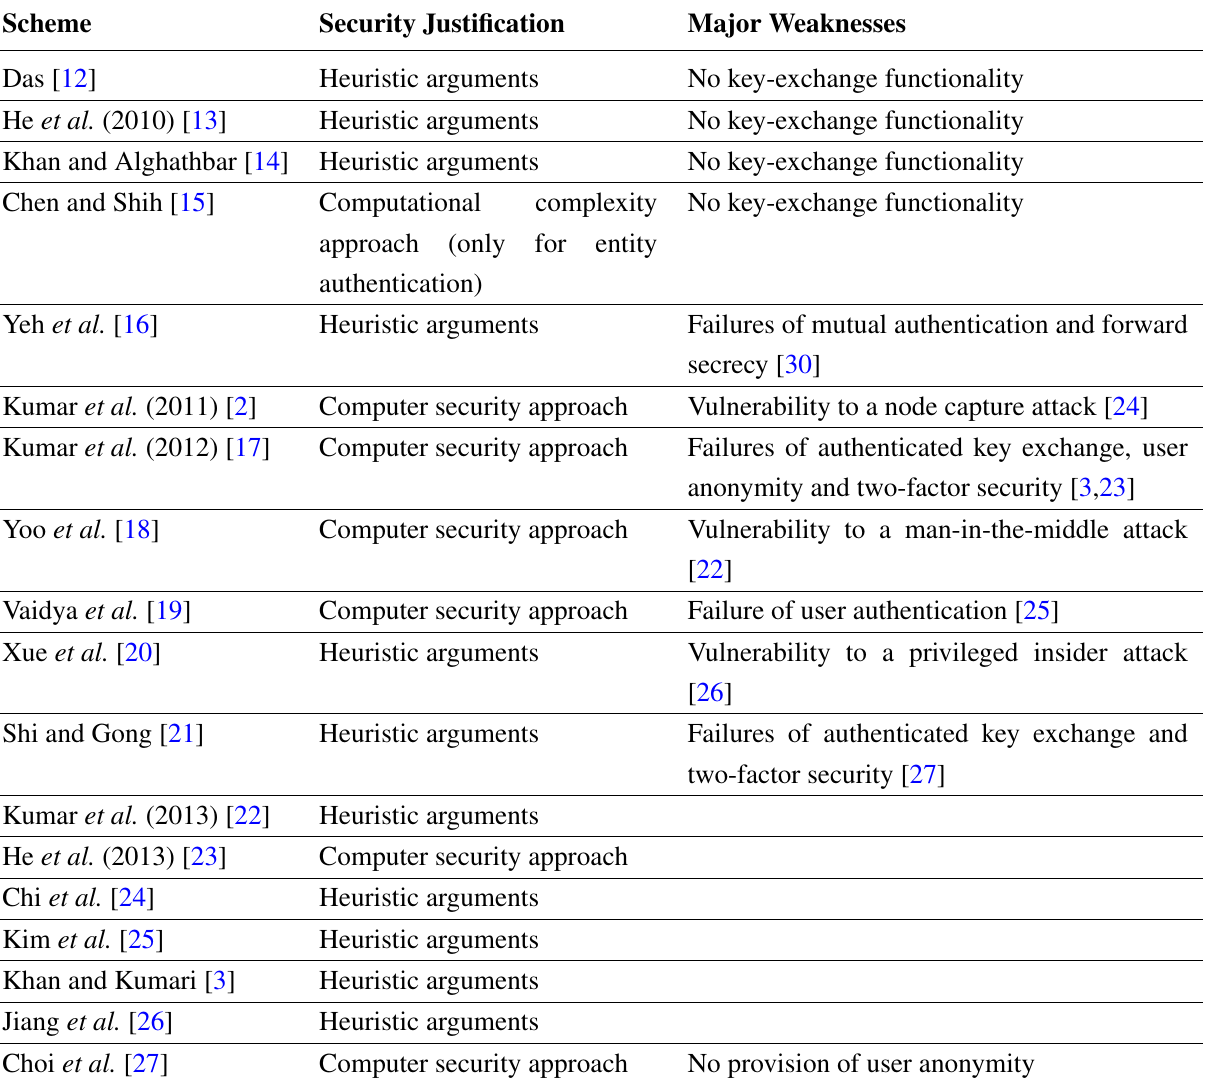
Table 1. A summary of security results for existing SUA - WSN (smart-card-based user authentication scheme for wireless sensor networks)